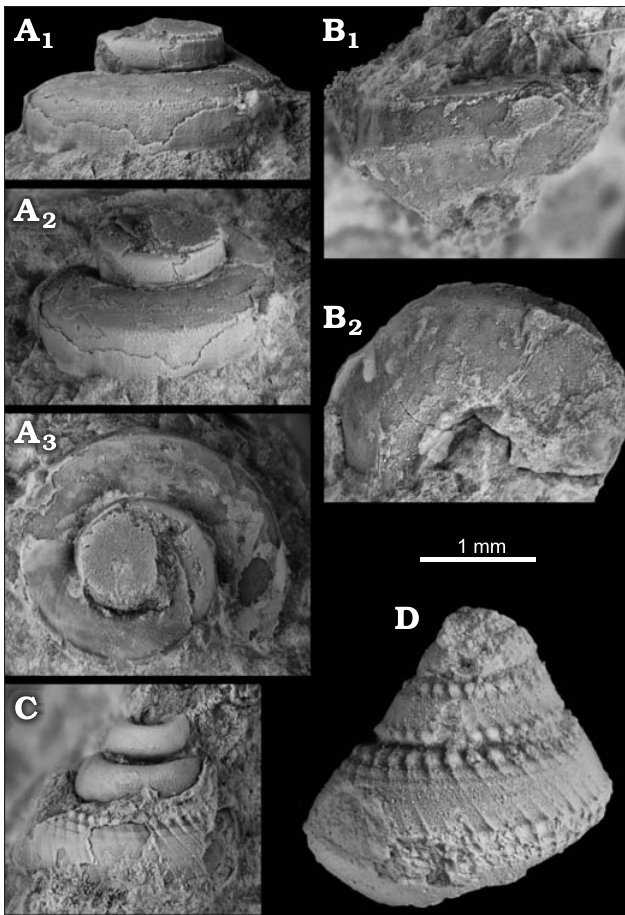
Fig. 12. Vetigastropoda from early Oligocene seep deposits at Cerro La Salina (block 1, A, D; block 2, C; block 9, B) Talara Basin, northern Peru. A , B . The colloniid Cantrainea sp. A . NRM Mo187040, specimen with base embedded in rock matrix in lateral (A 1 ), oblique (A 2 ) and apical (A 3 ) views. B . NRM Mo187041, specimen with exposed base in lateral (B 1 ) and basal (B 2 ) views. C , D . The trochoid incertae sedis. C . NRM Mo187042. D . NRM